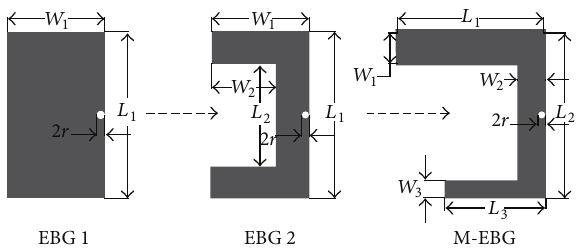
Figure 2: Evolution of the